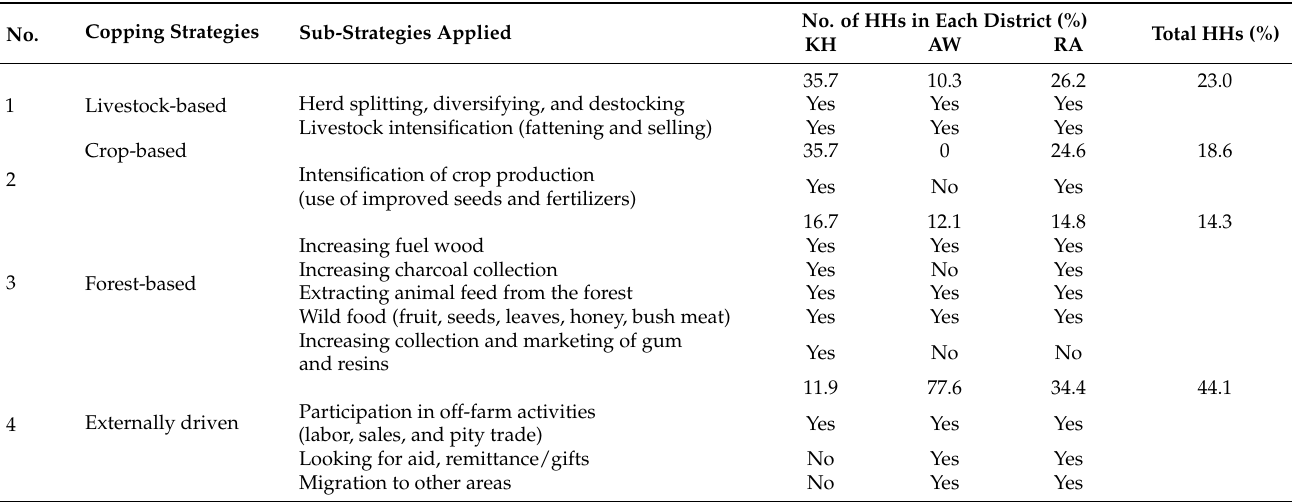
Figure 4. Food insecurity months of the three districts studied in Tigray Region. Table 4. Household coping strategy to manage climate change